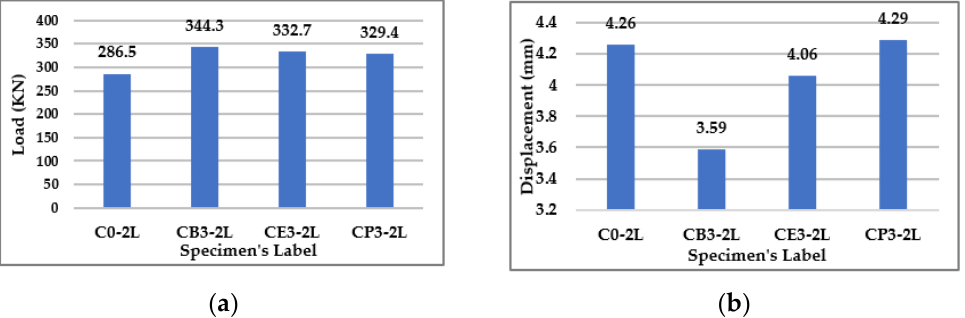
Figure 8. Results for Group (2). ( a ) Failure Loads for Group (2). ( b ) Deflection at the Mid Span of Beams in Group (2) at the same Load = 286.5 KN.